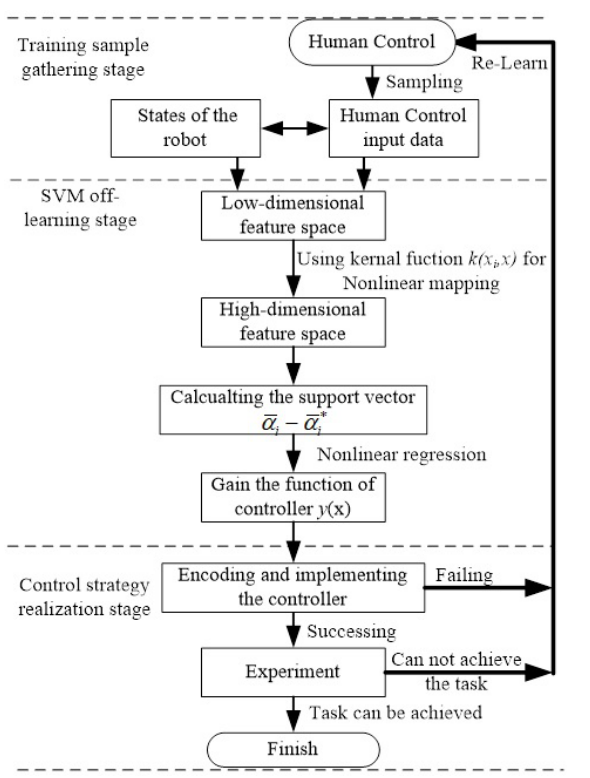
Fig. 5 Procedure of the learning